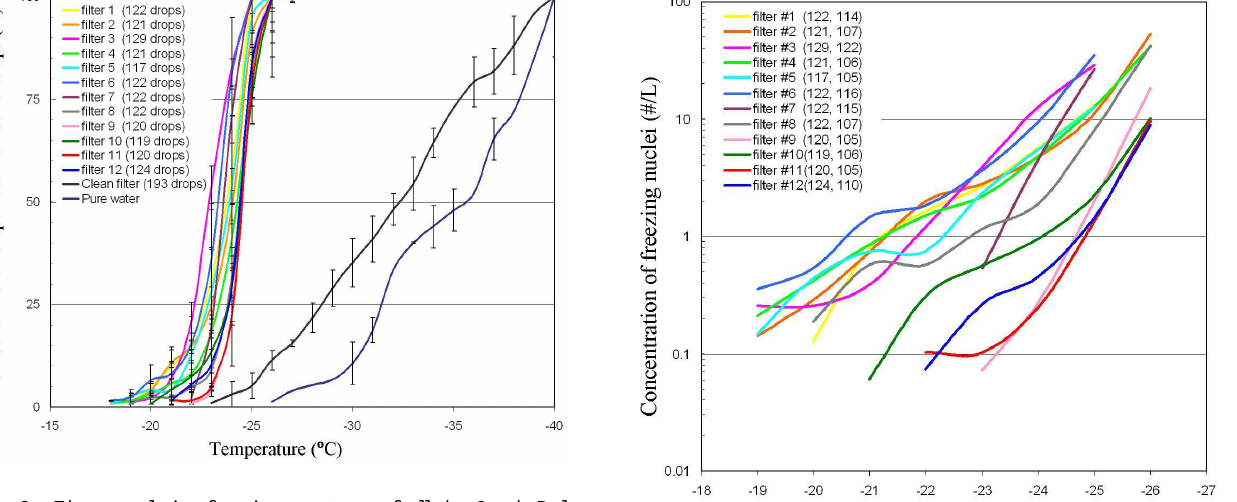
Fig. 3: The cumulative freezing spectrum of all the South Pole samples and the Fig. 3. The cumulative freezing spectrum of all the South Pole average spectrum of freezing temperature from clean blank filters and pure water. samples and the average spectrum of freezing temperature from The bars represent the standard deviation. clean blank filters and pure water. The bars represent the standard deviation.